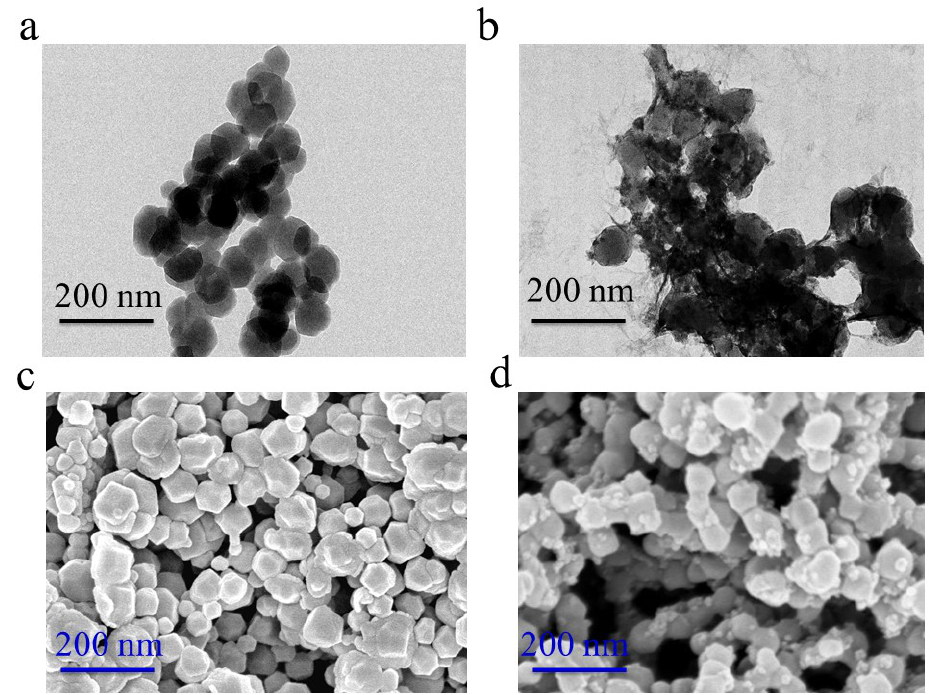
Figure 5. TEM ( a , b ), SEM characterizations ( c , d ) for MOF-AgNCs ( a , c ) and the products after the treatment of Mn 2+ and Pb 2+ ( b , d ).